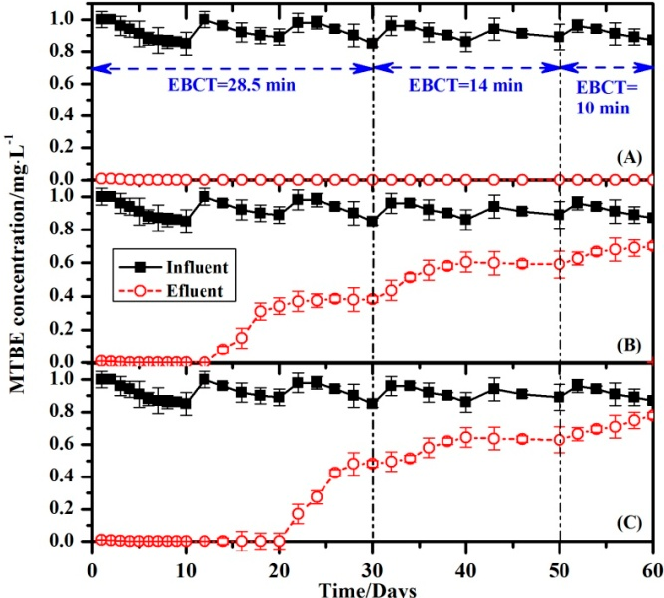
Figure 5. Biological filtration of MTBE through laboratory columns with 0.2-Ppy/GAC ( A ); PPy ( B ); and GAC ( C ) as adsorbents. The error bars represent the standard deviations from replicate measurements.